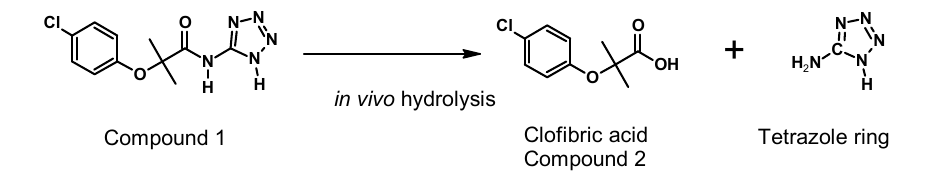
Figure 9. Hydrolysis reaction for Compound 1 . Table 6. The mean pharmacokinetics parameters for the Compound 2 generated both orally and intravenously.